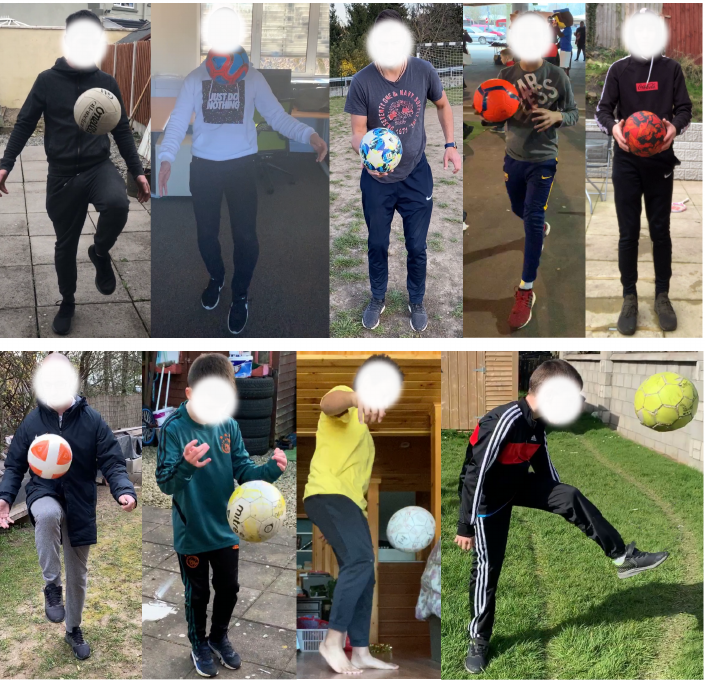
Figure 3. Representative images from our video database. Videos consists of several users playing a digital football game in diverse locations with varying lighting and